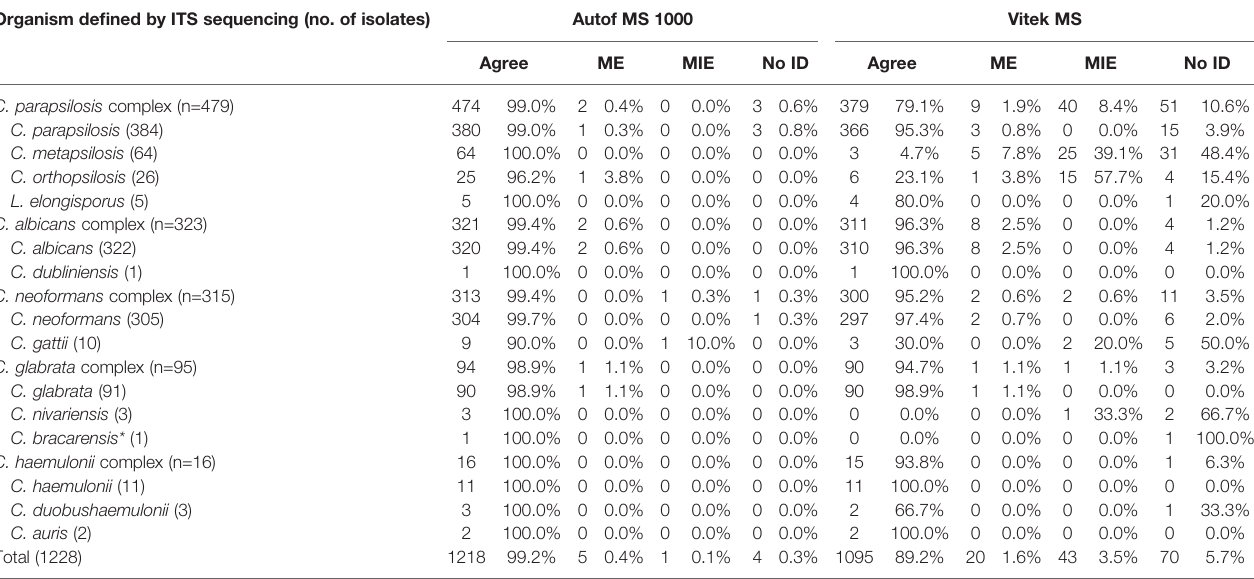
TABLE 1 | Results of matrix-assisted laser desorption ionization-time of fl ight mass spectrometry (MALDI-TOF MS) identi fi cation by Autof MS 1000 and Vitek MS. Organism de fi ned by ITS sequencing (no. of isolates) Autof MS 1000 Vitek